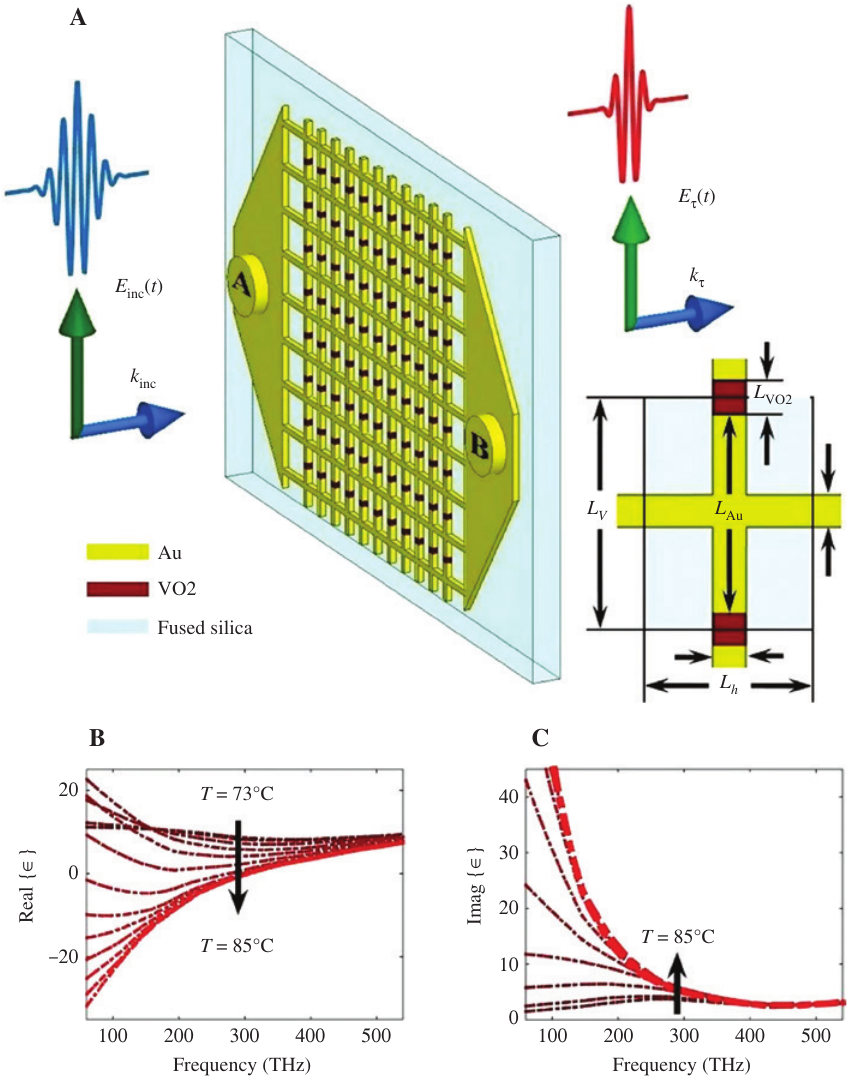
Figure 1: LSP based ultra-short pulse shaping configuration. (A) Dynamic pulse shaping schematic by reconfigurable LSP based on insulator to metal phase transition of VO2. (B) Real and (C) imaginary parts of VO2 relative permittivity changes by temperature. The darkest red shows the material property at 73 ° C, and brighter reds represent the property at higher temperatures up to 85 °